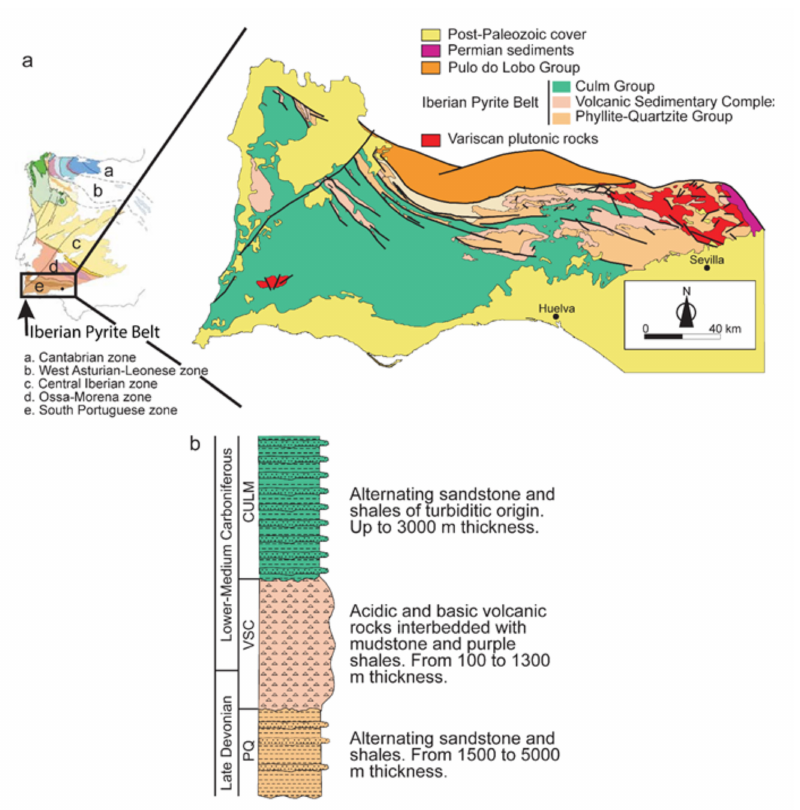
Figure 3. Geological ( a ) and stratigraphical ( b ) context of the Peña de Hierro area inside the Iberian Pyrite